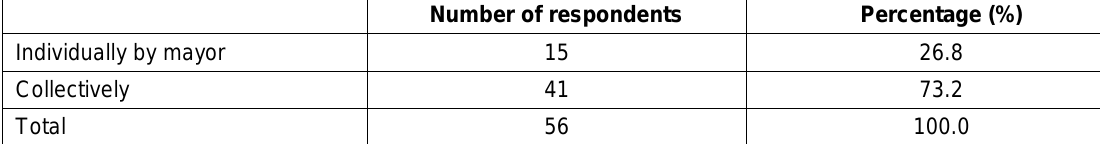
Table 6: Views on how SCC decisions are made (representatives and officials)